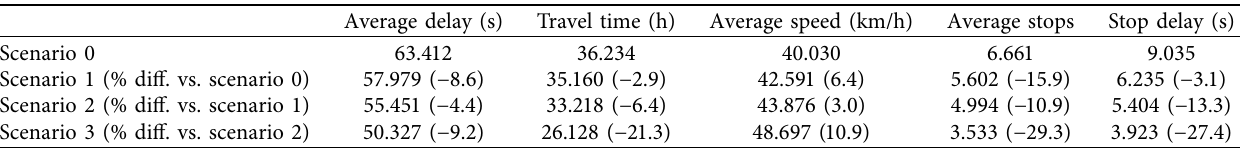
Figure 13: Scenario 3 vehicle trajectories. (a) Inner-lane vehicle trajectories. (b) Outer-lane vehicle trajectories. Table 2: Network